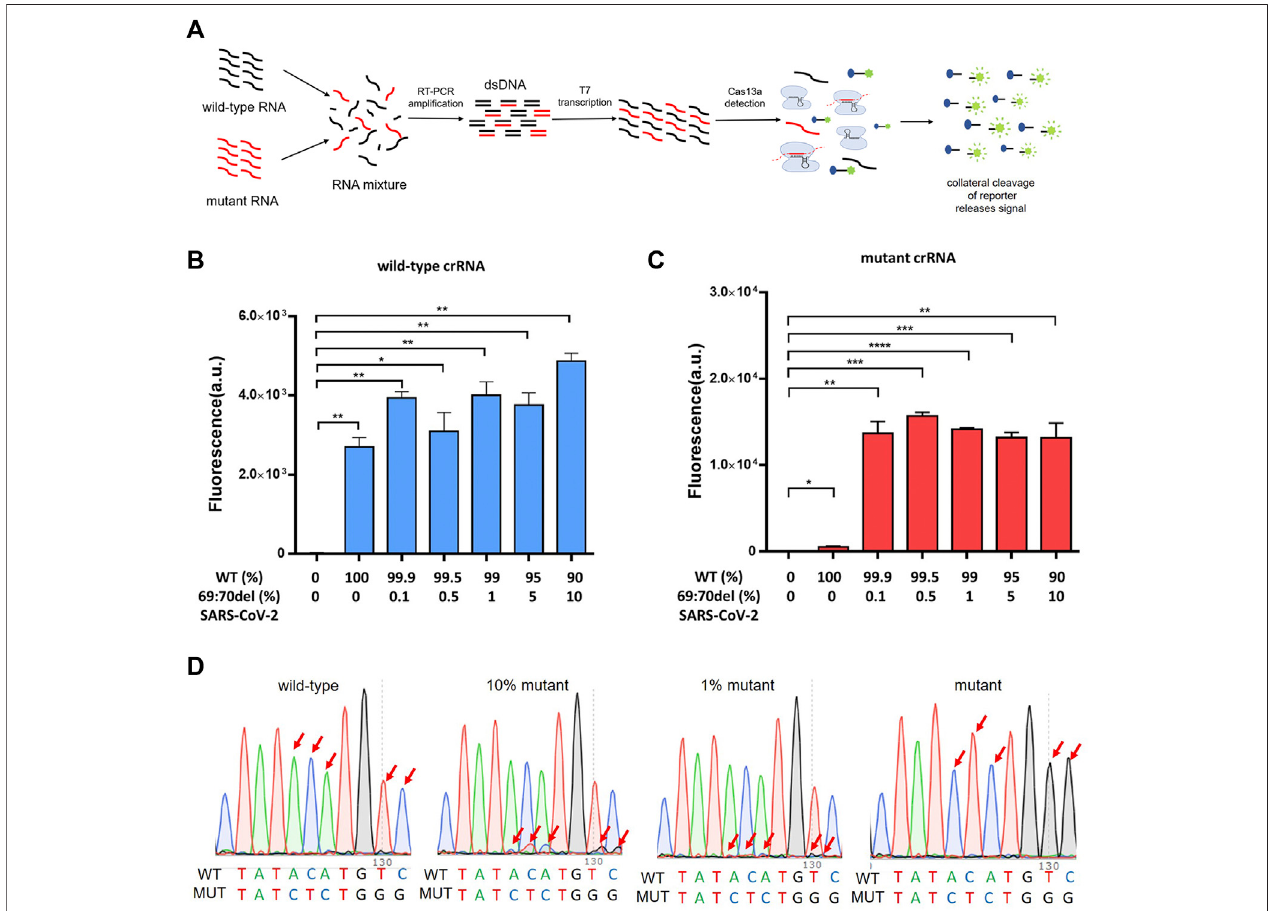
FIGURE 3 | The PCR-CRISPR method detects mixed mutant genes oflow proportion. (A) Schematic of PCR-CRISPR detection of mutant RNA on a background of wild-type RNA. (B) PCR-CRISPR detects mixed wild-type RNA of different proportions on a background of RNA mixture. (C) PCR-CRISPR detects mixed mutant RNA of different proportions on a background of RNA mixture. (D) Sequencing peak of Sanger sequencing for RNA mixtures of different proportions. ( n = 3 technical replicates, two-tailed Student t-test; **, p < 0.01; ***, p < 0.001; ****, p < 0.0001; ns, no signi fi cant difference; bars represent mean ± s.e.m.).